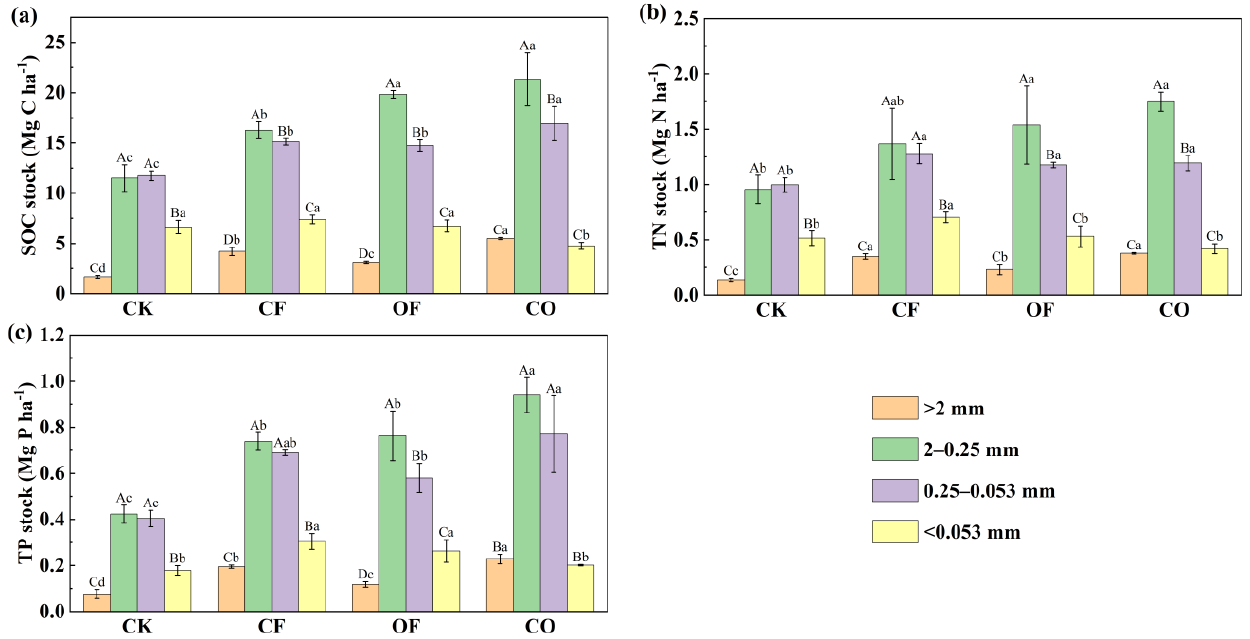
Figure 3. The stock of SOC ( a ), TN ( b ), and TP ( c ) in soil aggregate following different treatments. Different uppercase letters indicate significant differences in aggregate fraction within the same treatment ( p < 0.05), and different lowercase letters indicate significant differences between different treatments within the same aggregate fraction ( p < 0.05). CK, no fertilizer; CF, chemical fertilizer; OF, organic fertilizer; CO, chemical fertilizer (50% N) plus organic fertilizer (50% N).